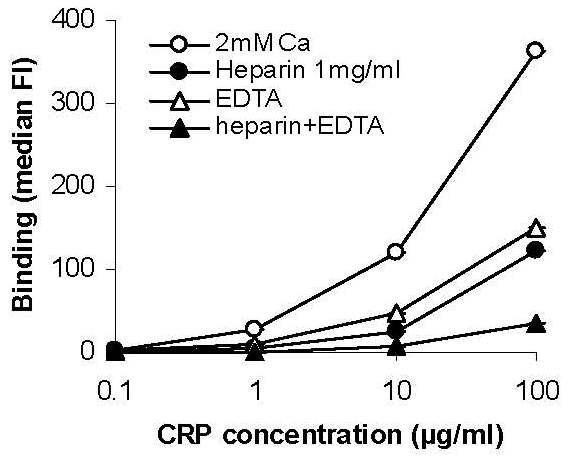
Additive inhibition of CRP binding by EDTA and heparin. FITC-CRP was incubated with cultured human neutrophils in the presence of 2 mM Ca2+ or 5 mM EDTA, with or without pre-incubation with 1 mg/ml heparin. Binding to late apoptotic neutrophils was assessed by gating on the propidium iodide-positve cell population. The inhibitory effects of EDTA and heparin on CRP binding were additive.